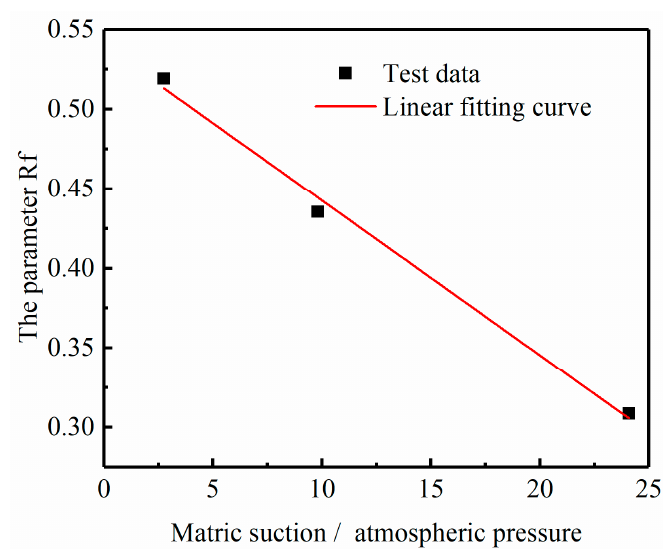
Ph Figure 12. The R f − h m curve of the soft P a m R − Figure 12. The curve of the soft soil. f a Table 5. Values of the parameters of different creep models.